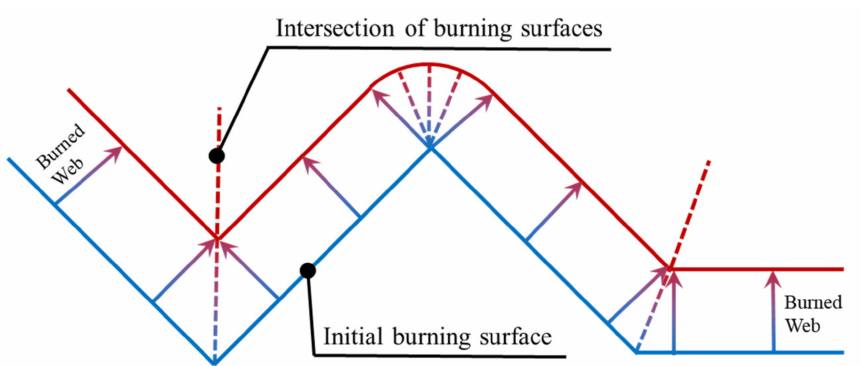
Figure 5. Illustration of burning surface regression.